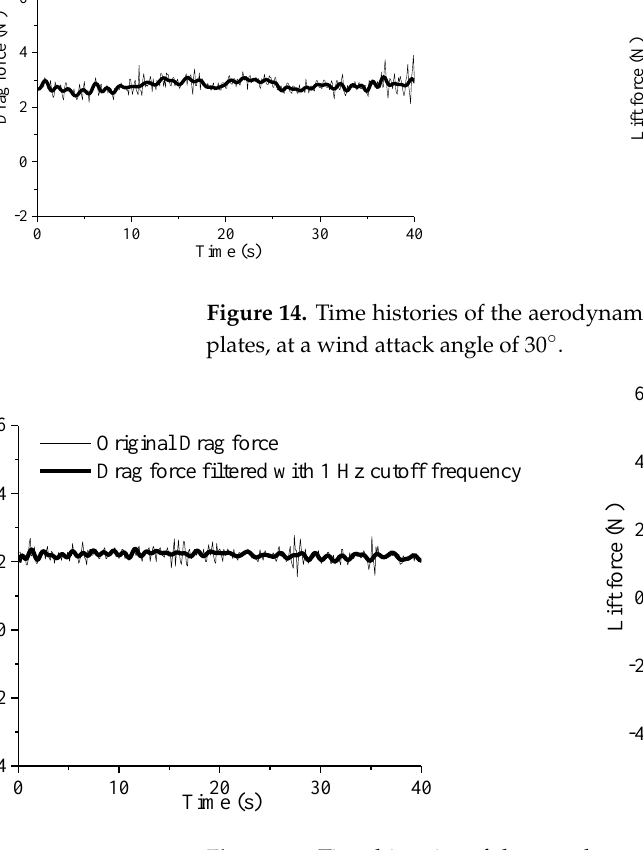
Figure 15. Time histories of the aerodynamic forces in conditions of tunnel highway and no end plates, at a wind attack angle of 30°.